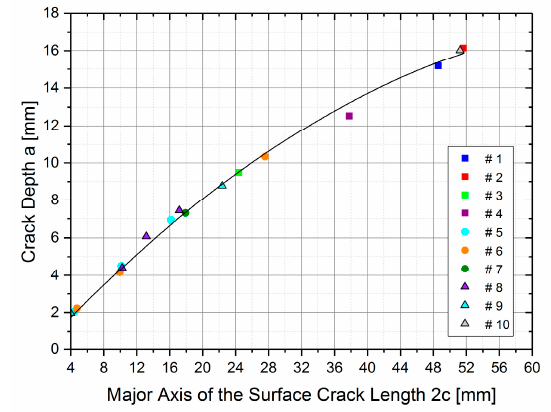
Figure 6. Illustration of crack depth as a function of surface crack length 2 c .